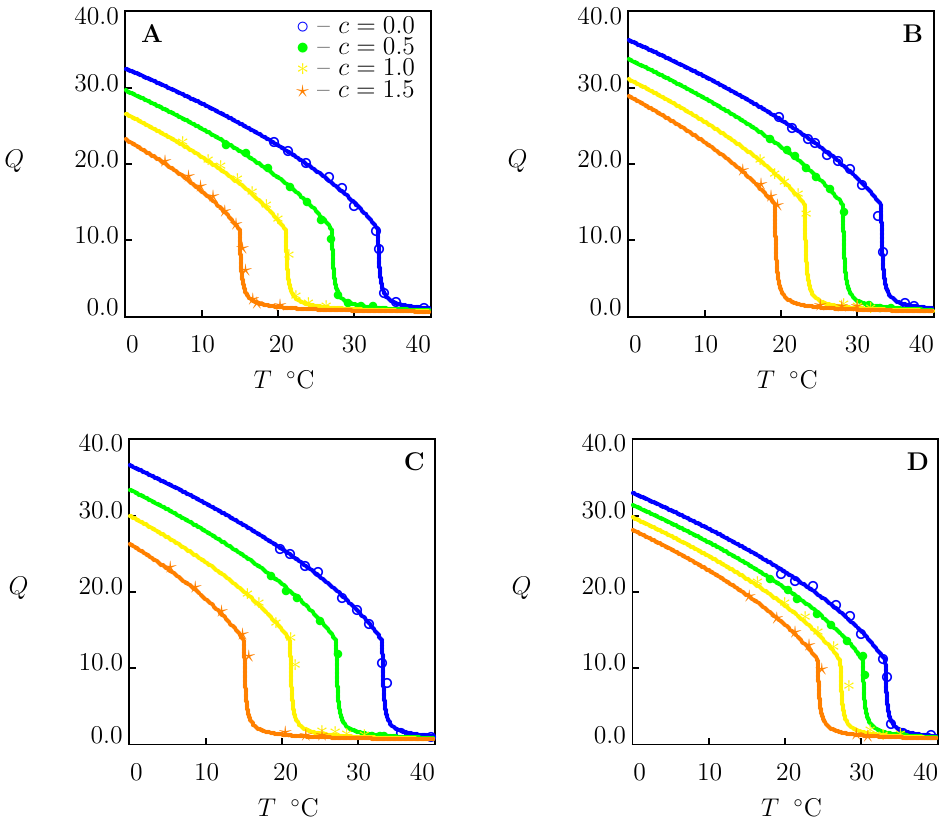
Figure 4. Equilibrium degree of swelling Q versus temperature T . Symbols: experimental data on PNIPAAm gel [39] in aqueous solutions of salts with various concentrations c M. ( A )—NaCl, ( B )—LiNO 3 , ( C )—NaNO 3 , ( D )—NaI. Solid lines: results of numerical